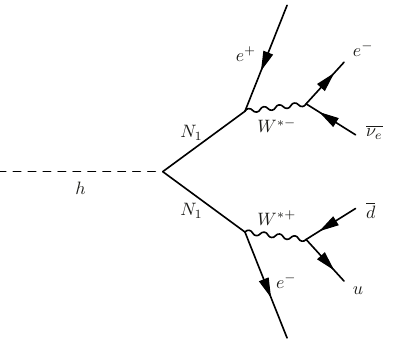
Figure 2 . An example of a Higgs decay process through o(cid:11)-shell W-bosons into (cid:12)nal states with